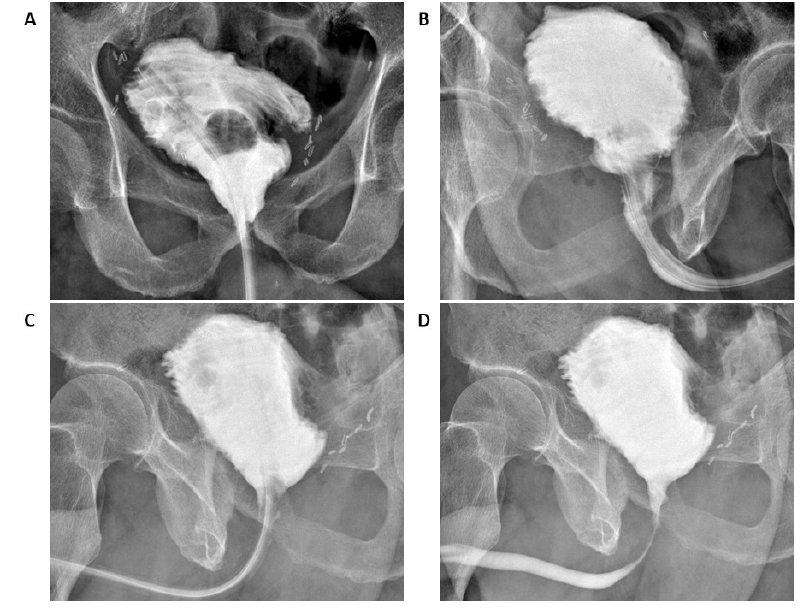
Figure 5. Postoperative cystogram after 14 days. Panel ( A ): coronal plane; ( B ) right to left sagittal plane; ( C ) left to right sagittal plane before catheter removal; ( D ) left to right sagittal plane after catheter removal.